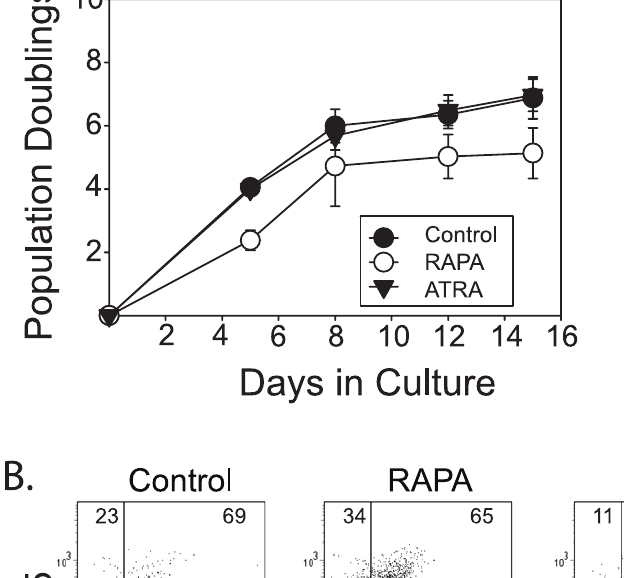
activity after a single round of restimulation and culture, while RAPA-treated Tregs robustly suppressed effector cell division in all cultures ( Fig 2D , and data not shown). These data indicate that ATRA does not promote the expansion of cells with a durable Treg phenotype, and furthermore, these data emphasize the difficulties of using FOXP3 expression as the sole surrogate for Treg activity.